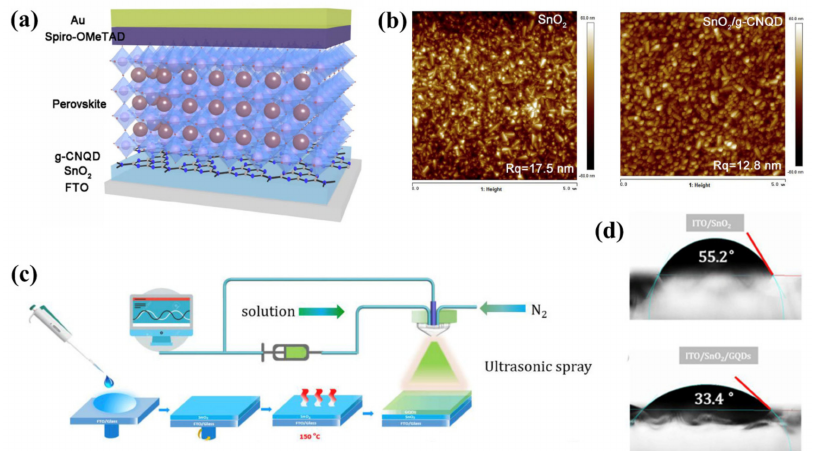
Figure 3. ( a ) Schematic representation of the structure of PSCs with graphdiyne carbon nitride QDs as an interfacial layer. Reproduced from [77], with permission from Elsevier, 2020. ( b ) AFM images of pristine SnO 2 film and SnO 2 /g-CN QD film. Reproduced from [77], with permission from Elsevier, 2020. ( c ) Schematic diagram of GQDs deposited by ultrasonic atomization. Reproduced from [27], with permission from Elsevier, 2019. ( d ) Comparison of the water contact angles of SnO 2 and SnO 2 /GQD films. Reproduced from [27], with permission from Elsevier,